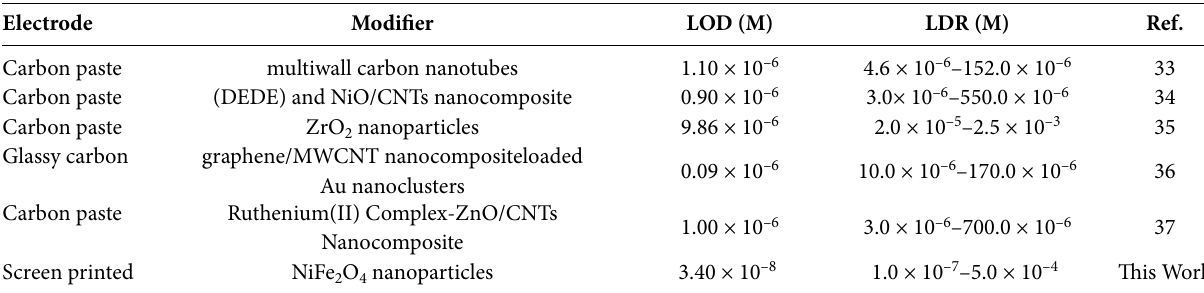
Table 1. Comparison of analytical parameters for the determination of folic acid by various electrodes. Electrode